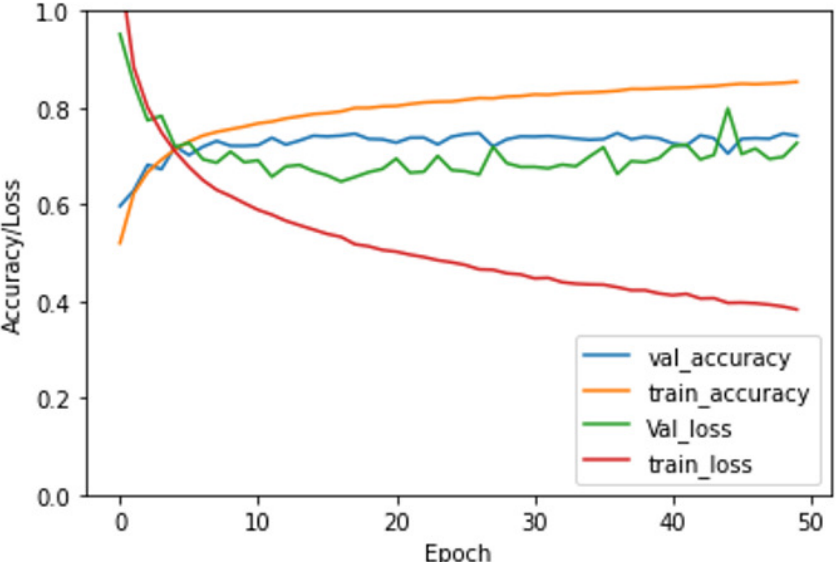
Figure 5. Training loss and accuracy as well as validation loss and accuracy in dataset for our proposed CNN M